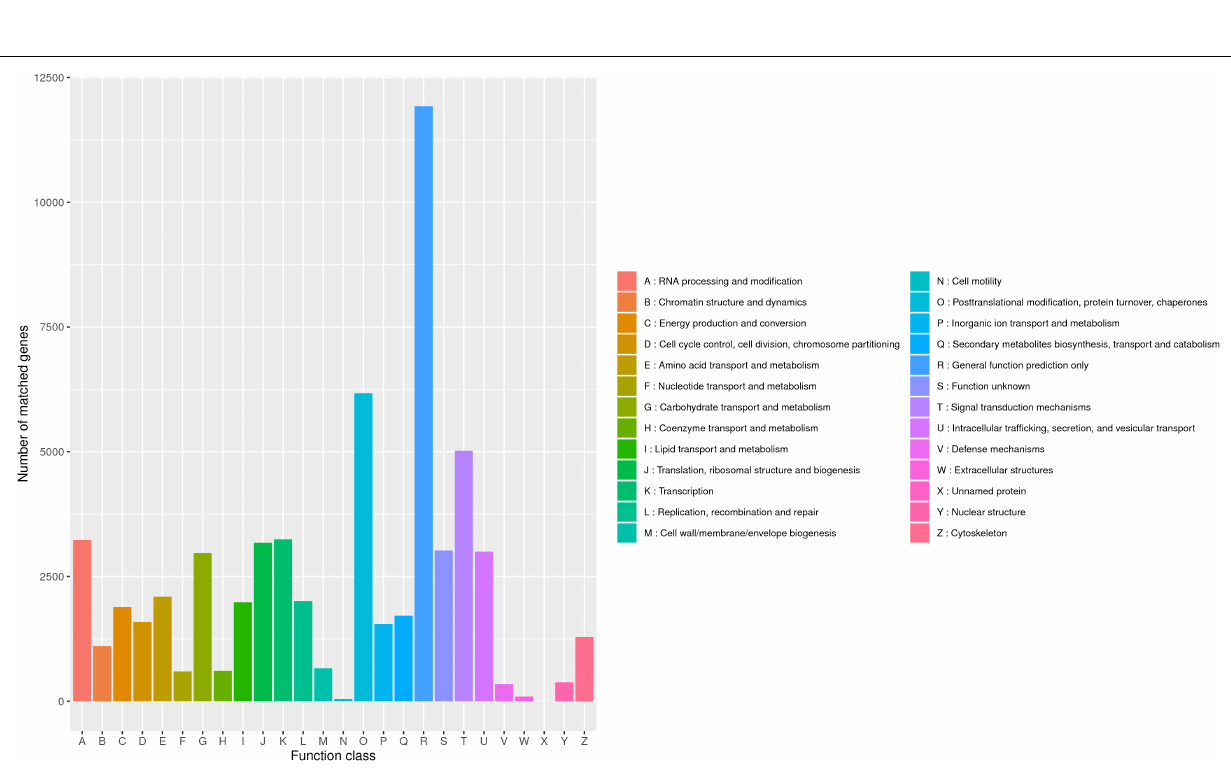
FIGURE 4 | Classification of B. striata in KOG. The transcripts could be roughly divided into 26 categories according to their function (represented by A-Z), and the number of genes in each category was